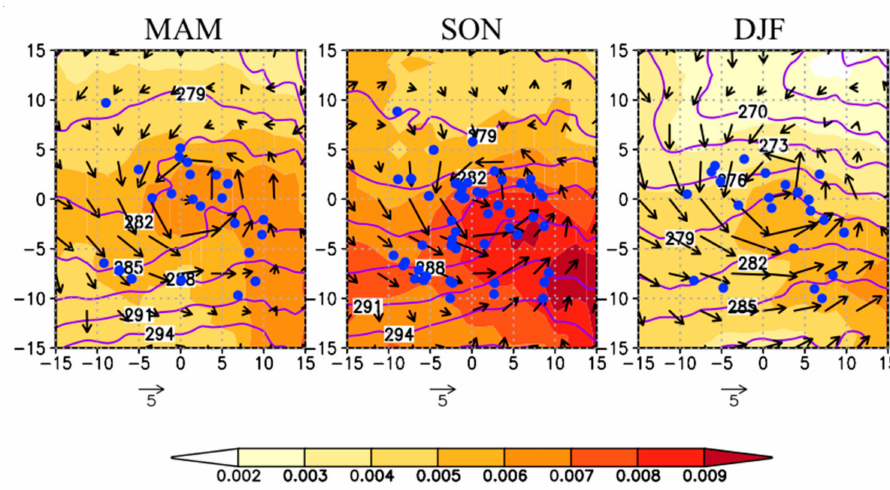
Figure 6. Cyclone relative composite: 950 hPa water vapor specific humidity (kg kg − 1 ; colors), temperature (K; line) and wind vectors in ( left ) spring, ( middle ) autumn, and ( right ) winter. Cyclone-relative tornado locations are shown with blue points.